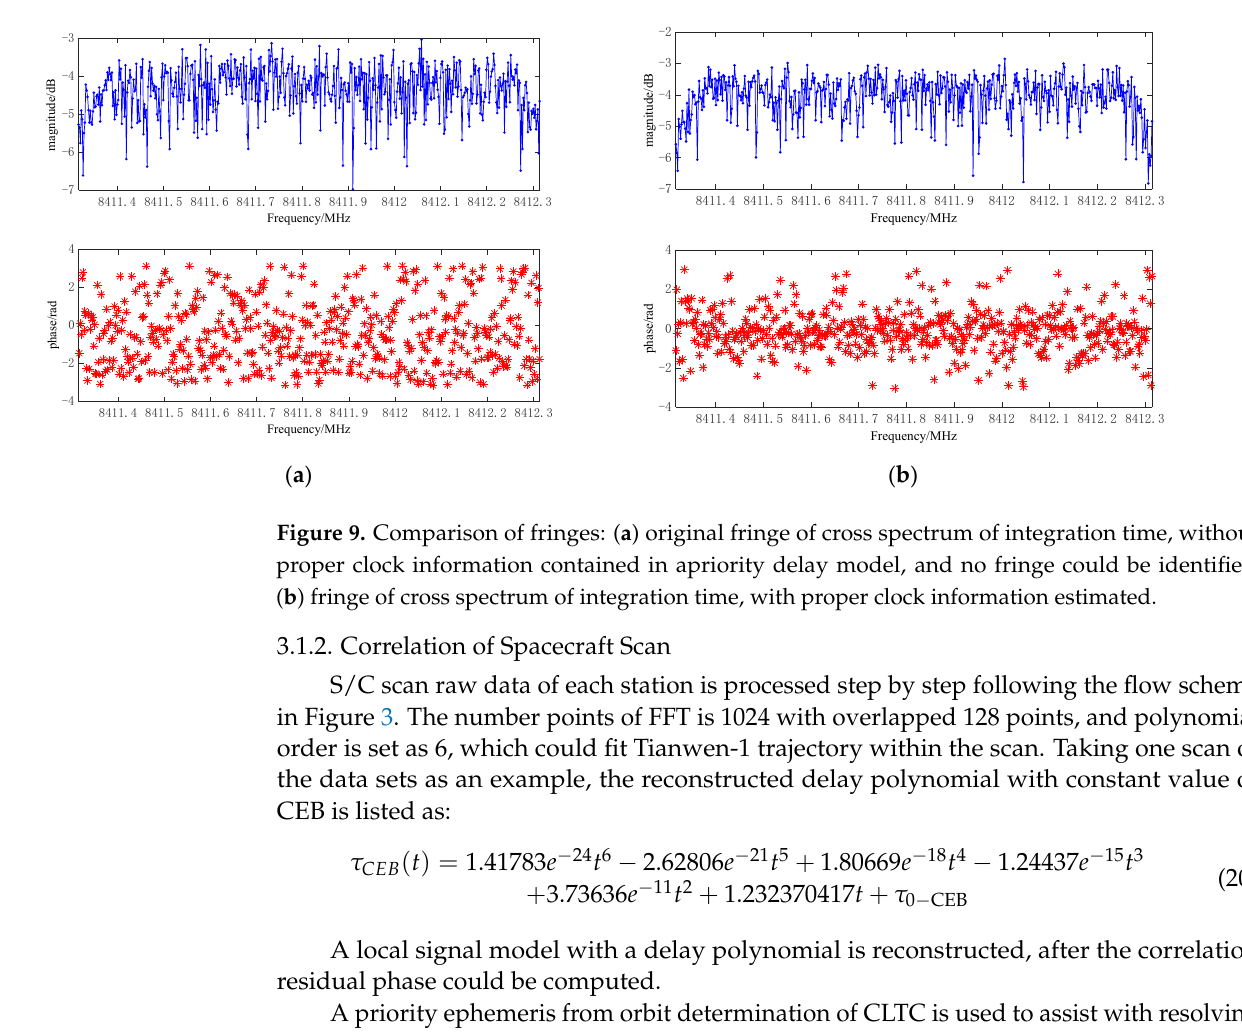
Figure 8. Iteration statistics of the test data: ( a ) location index of maximum magnitude of evaluation vector for each iteration; ( b ) maximum magnitude of evaluation vector for each iteration. The iteration which satisfies both the maximum magnitude and index limit corresponds to the clock information, where clock offset is about 2.7 microseconds and rate is about 0.16 picoseconds per second.